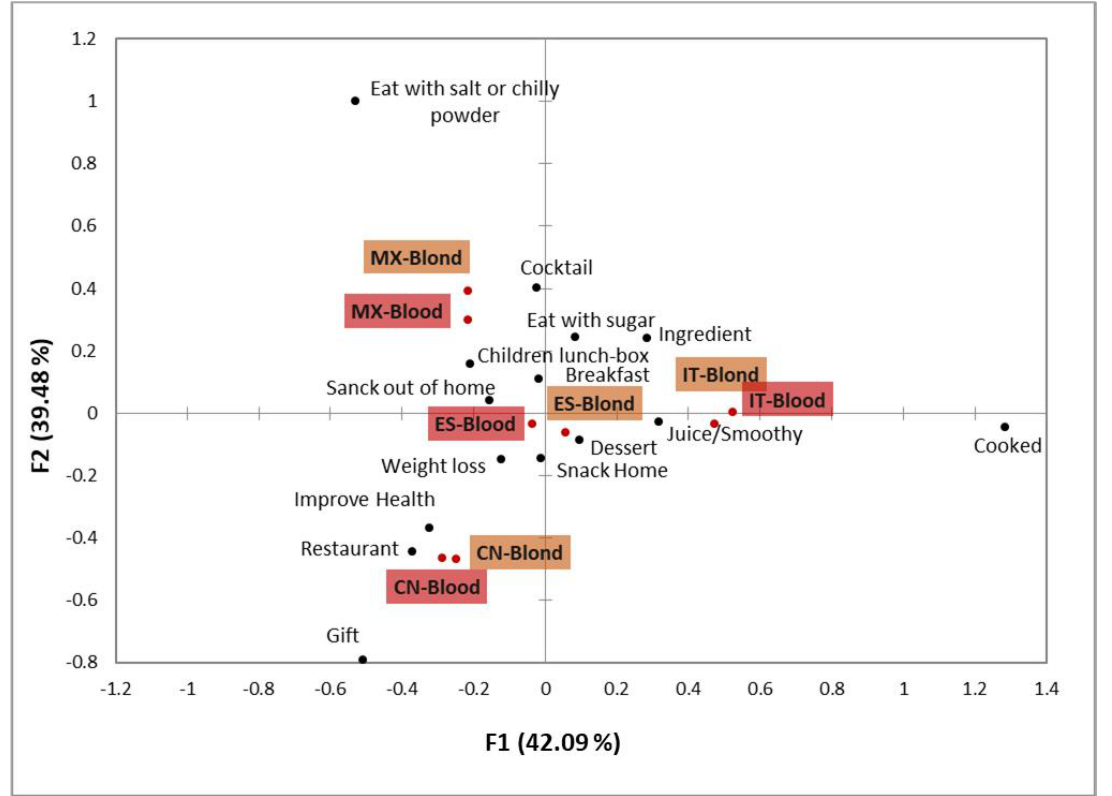
Figure 2. Correspondence analysis for the consumption contexts. The data used to perform the analysis were the percentage of participants (of those who stated consuming each orange type habitually) who selected each context. ES — Spain, IT — Italy, CN — China and MX — Mexico.